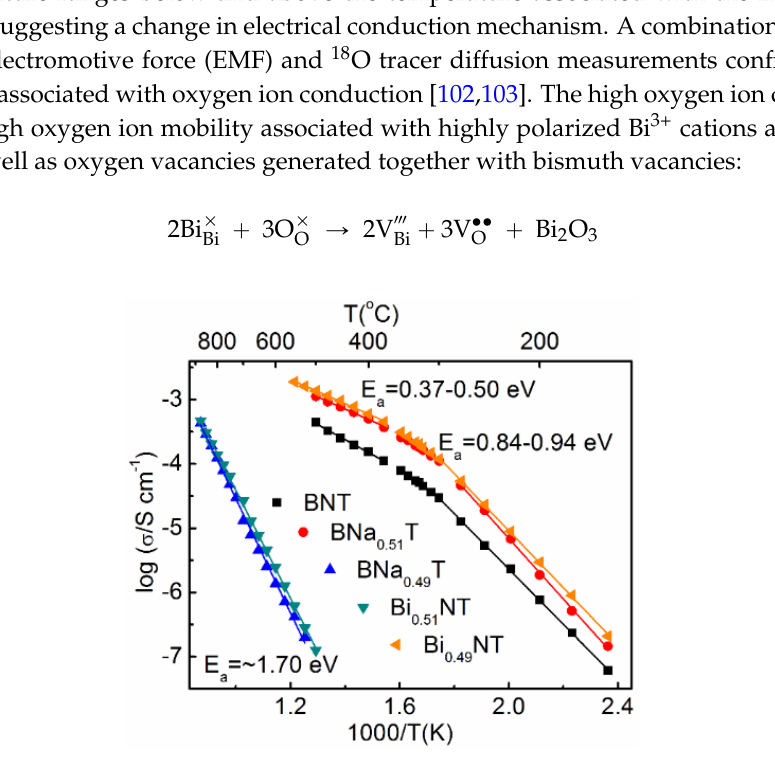
Figure 5. Arrhenius ‐ type plots of bulk conductivity for nominal compositions Bi 0.5 Na 0.5 TiO 3 (BNT), Bi 0.49 Na 0.5 TiO 2.985 (Bi 0.49 NT), Bi 0.51 Na 0.5 TiO 3.015 (Bi 0.51 NT), Bi 0.5 Na 0.49 TiO 2.995 (BNa 0.49 T) and Bi 0.5 Na 0.51 TiO 3.005 (BNa 0.51 T) (from references